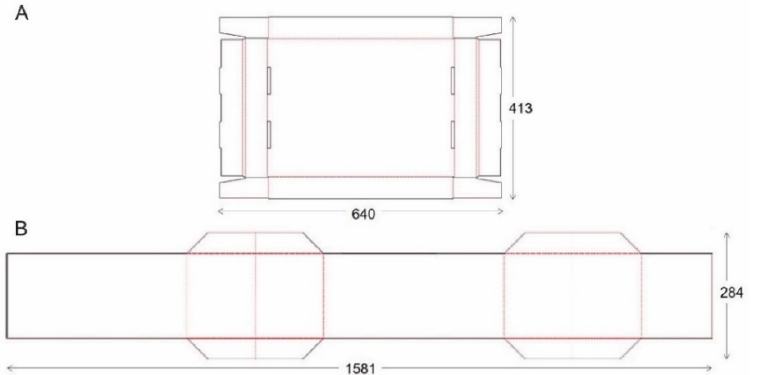
Figure 3. Technical drawing of ‘bottom/lid’ ( A ) and ‘mantle’ of the tripartite foldable box ( B ). The cardboard used to assemble the box was initially conditioned at 50 ± 2% relative humidity (RH) and 23 ± 1 °C for 48 h (ISO 187 standard) before functionality testing was performed. The cardboard’s single sheet thickness (mm) was determined using a L&W Micrometer, type SE 050 (Munich, Germany) in accordance with the ISO 3034 standard.